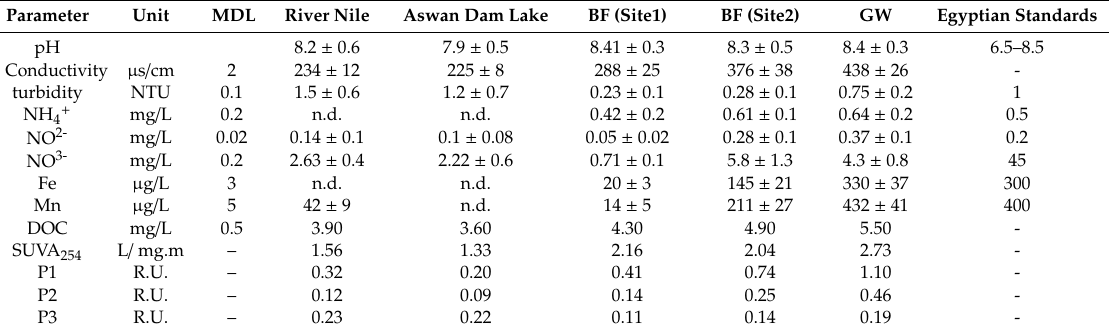
Table 3. Quality parameters of surface waters, bank filtrates, and groundwater sources. Parameter